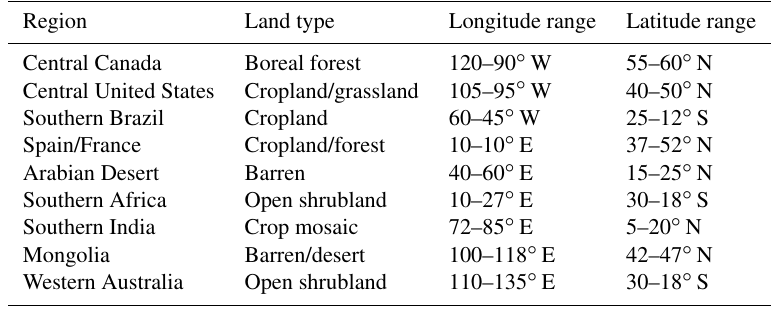
Table 2. Selected geographical regions for analysis.